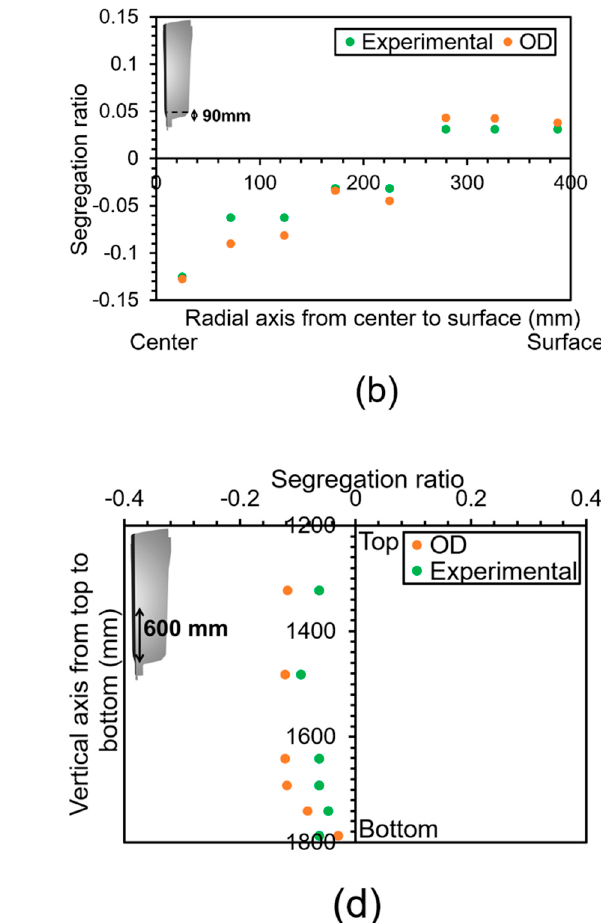
Figure 6. Carbon macrosegregation ratio when solidification is complete: ( a ) Along the radial axis at the hot top (height of 1659 mm from the bottom), ( b ) Along the radial axis at the bottom (height of 90 mm from the bottom), ( c ) Along the central axis, from the bottom toward the top at 300 mm distance below the hot top, and ( d ) Along the central axis from the bottom toward the top at a 600 mm distance above the ingot bottom .